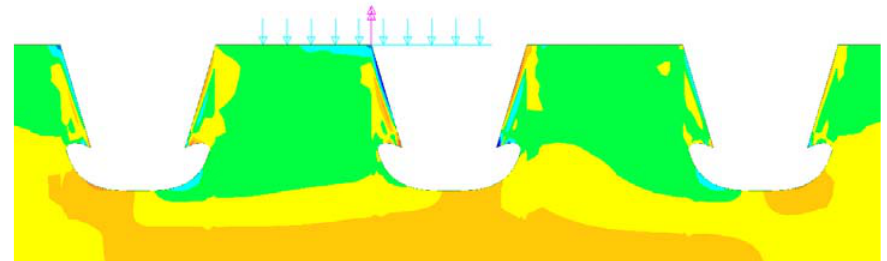
Figure 7: Stress distribution at diaphragm (Abruzzese et al.,